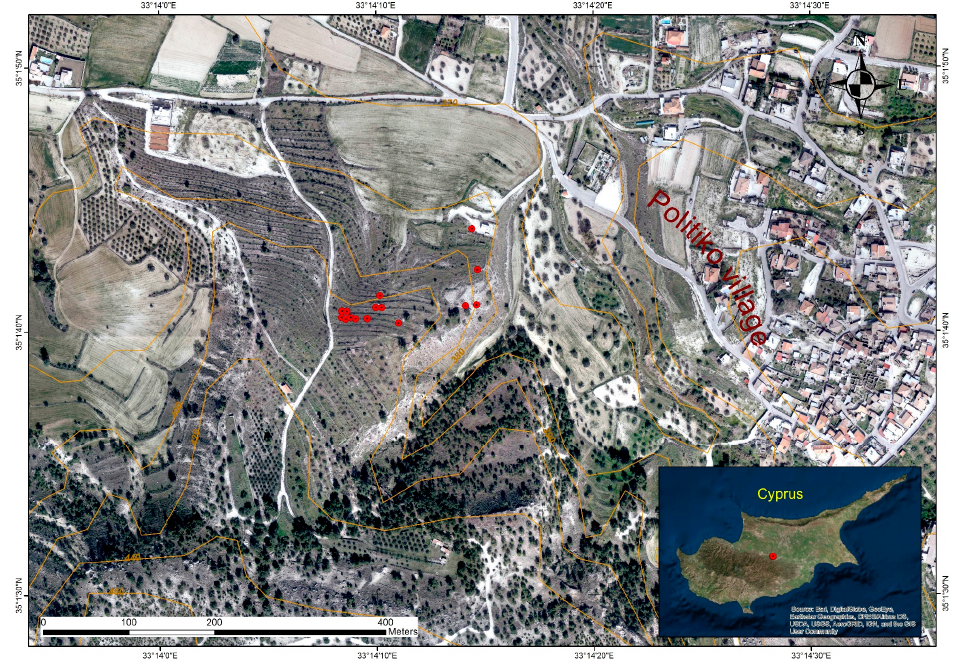
Figure 2. Map indicating the case study area in the southwestern part of the modern village of Politiko, Nicosia District. Red dots indicate looted tombs which have been detected during the in situ investigation and mapped with GNSS (February 2016).